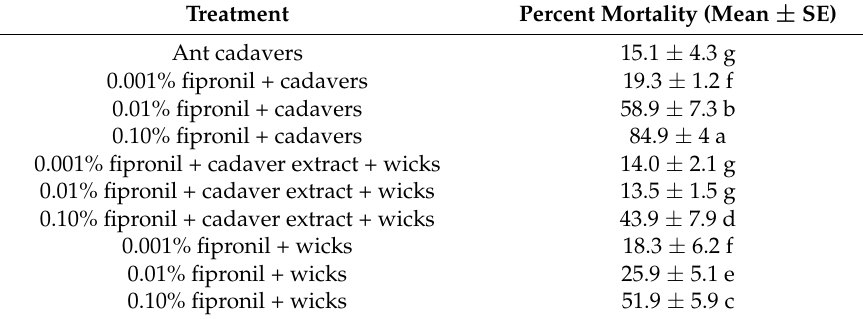
Table 2. Mortality of Argentine ants three days following exposure to insecticide-treated and untreated ant cadavers and paper wicks containing a methylene chloride extract of ant cadavers. Means (based on n = 6 replications) followed by the same letter are not significantly different